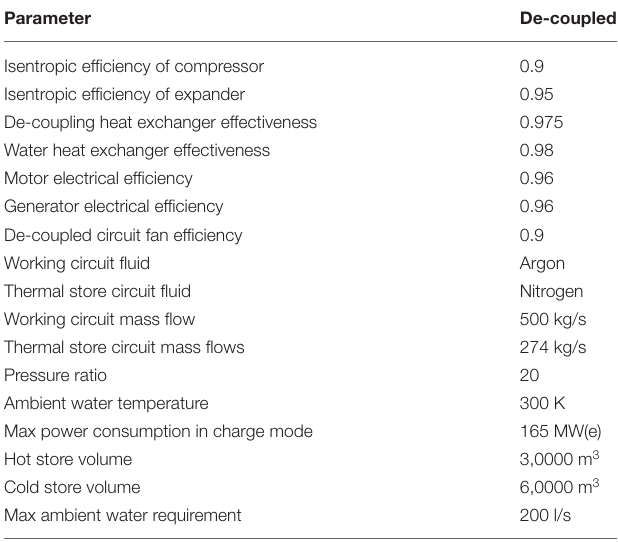
TABLE 1 | Summary of outline design